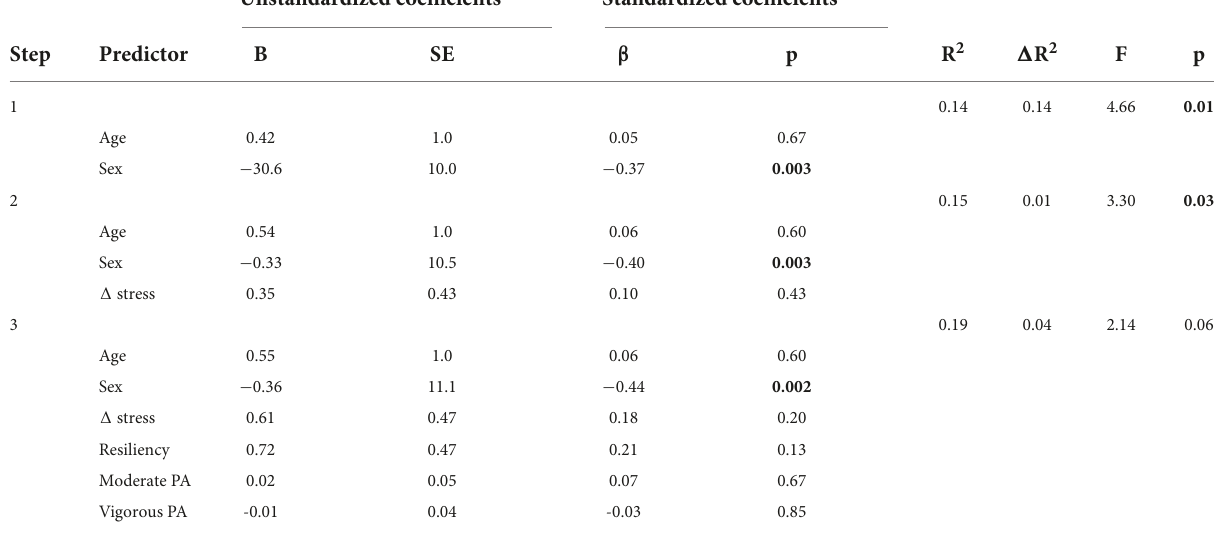
TABLE 6 Hierarchical regression coefficients: